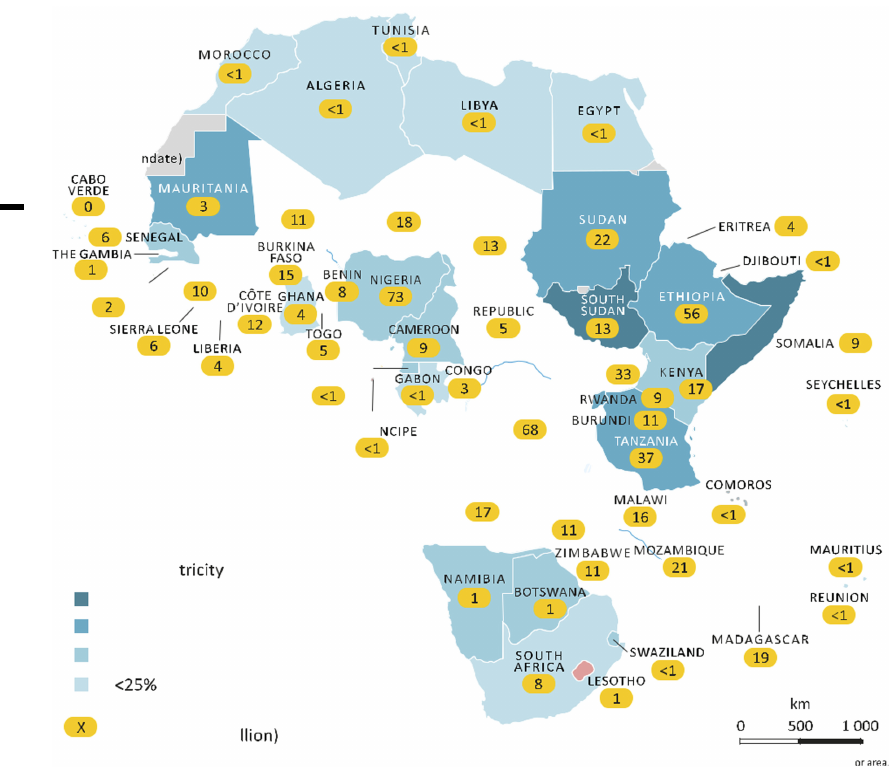
Figure 1. Population without In Sub-Saharan Africa, 18 countries had electricity access rates above 50% in 2016 access to electricity in Africabycountry,2016 Source(s): World Energy Outlook, 2017